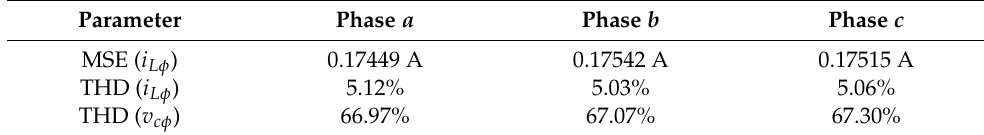
Table 8. Simulation results for PI in the presence of parametric uncertainties.